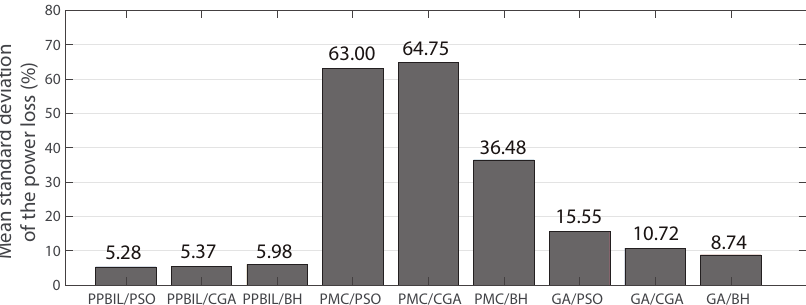
Figure 12. Mean standard deviation of the power loss for the 69 bus test